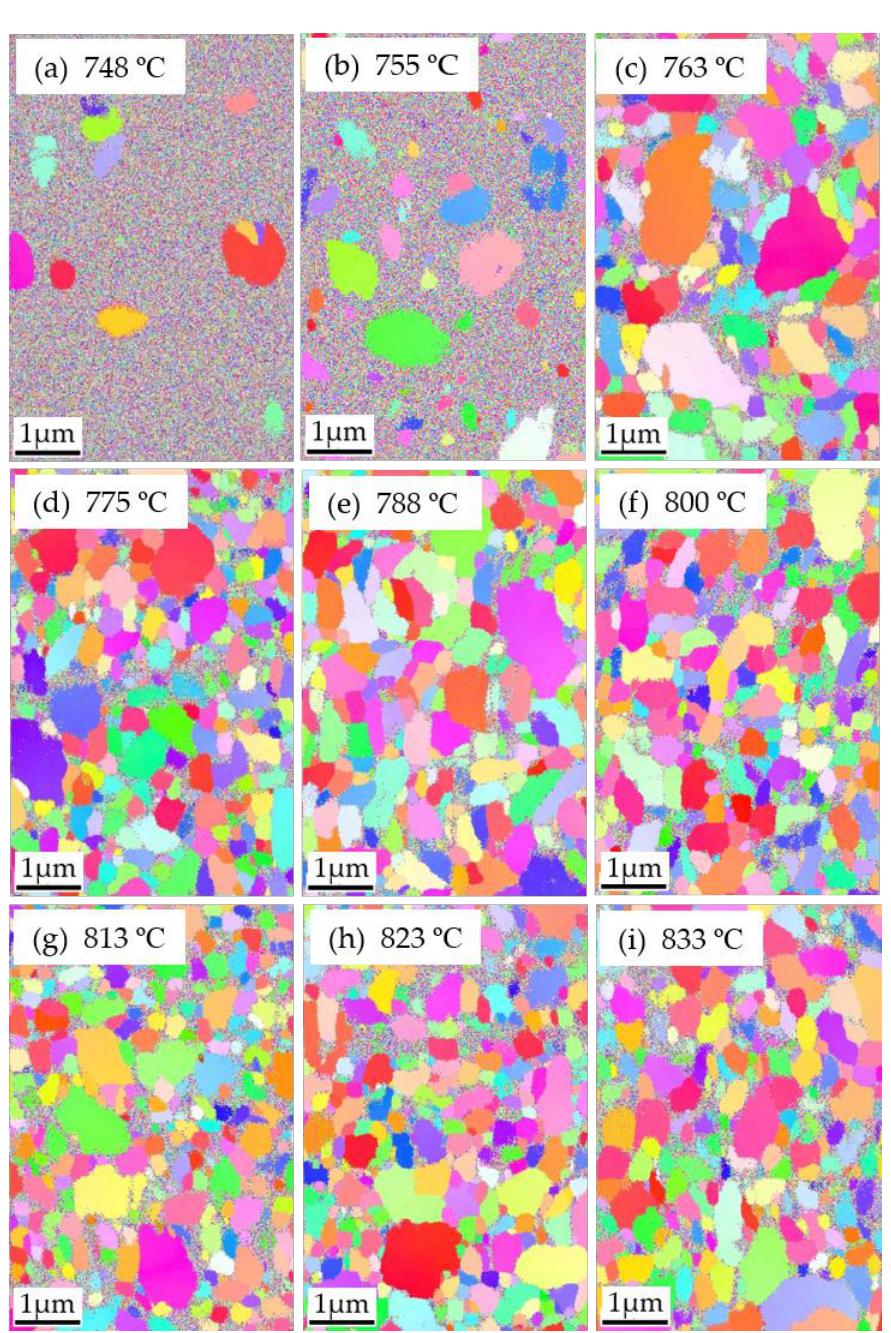
Figure 8. EBSD map of C 0.1 S 0.9 BT FeFETs with different annealing temperature, ( a ) 748 °C, ( b ) 755 °C, ( c ) 763 °C, ( d ) 775 °C, ( e ) 788 °C, ( f ) 800 °C, ( g ) 813 °C, ( h ) 823 °C, and ( i ) 833 °C. Color coded unit triangle is the same as Figure 2f.